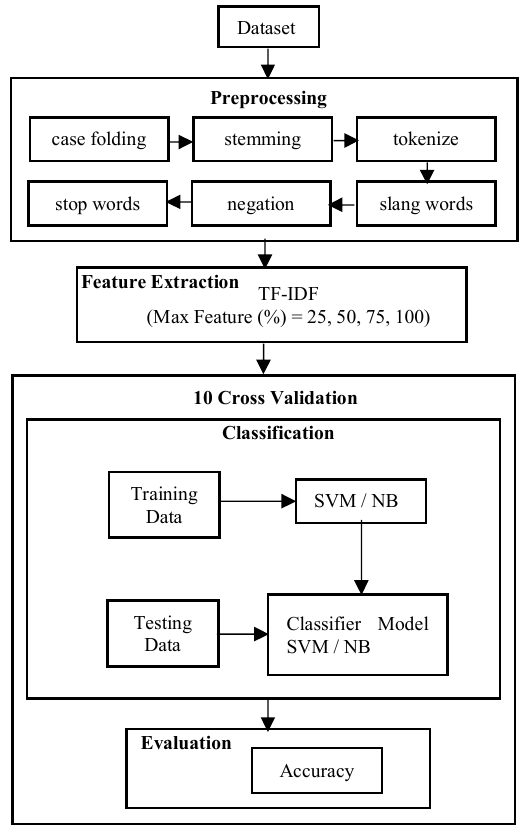
Figure 1. Research